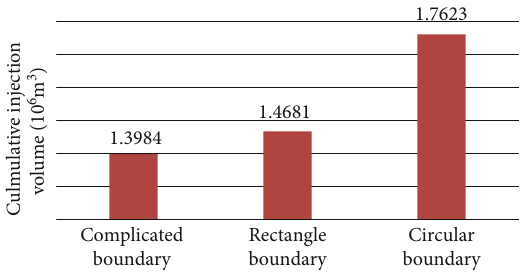
Figure 6: The cumulative CO after 720